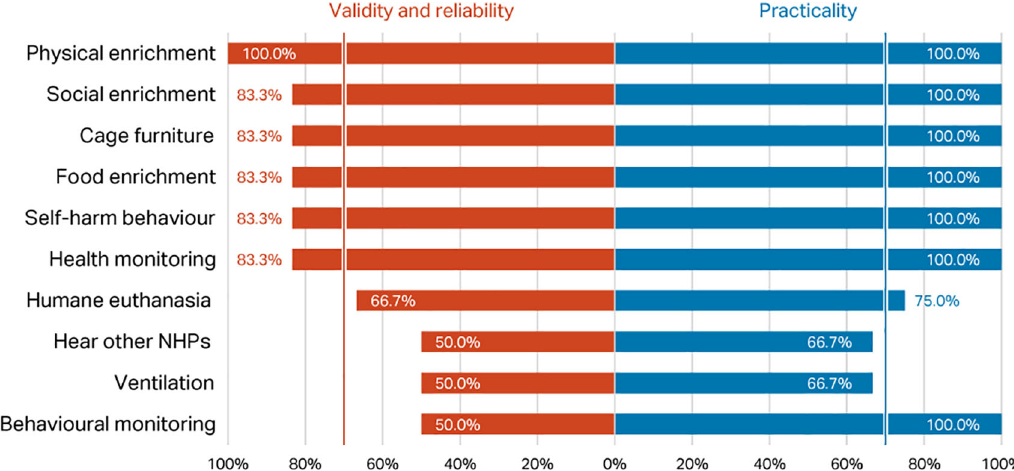
Figure5.Validityandreliabilityandpracticabilityscores(%ofrespondents)formarmosets,toptenindicators from Truelove et al . (2020) (n=6